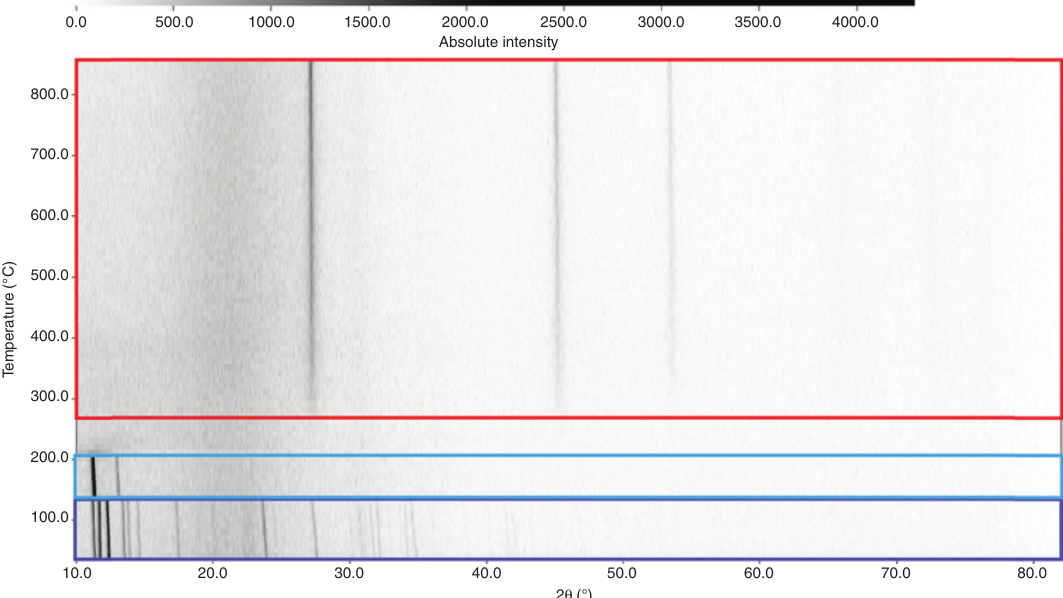
Figure 6: Temperature-dependent PXRD of A in sealed quartz glass capillaries, confirming the formation of Ge (ICDD No.